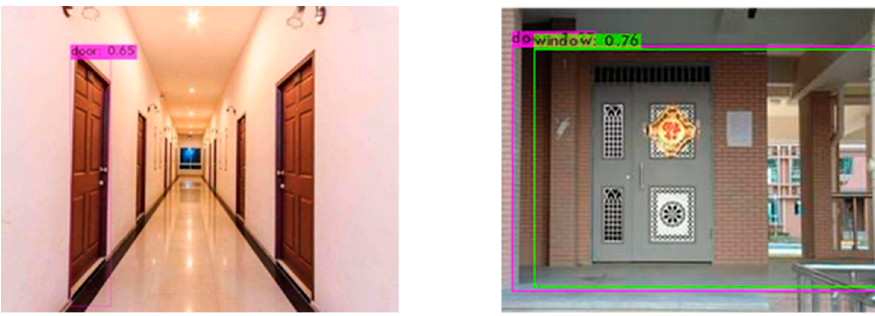
Figure 7. Error detection and missed detection in YOLOV3 .